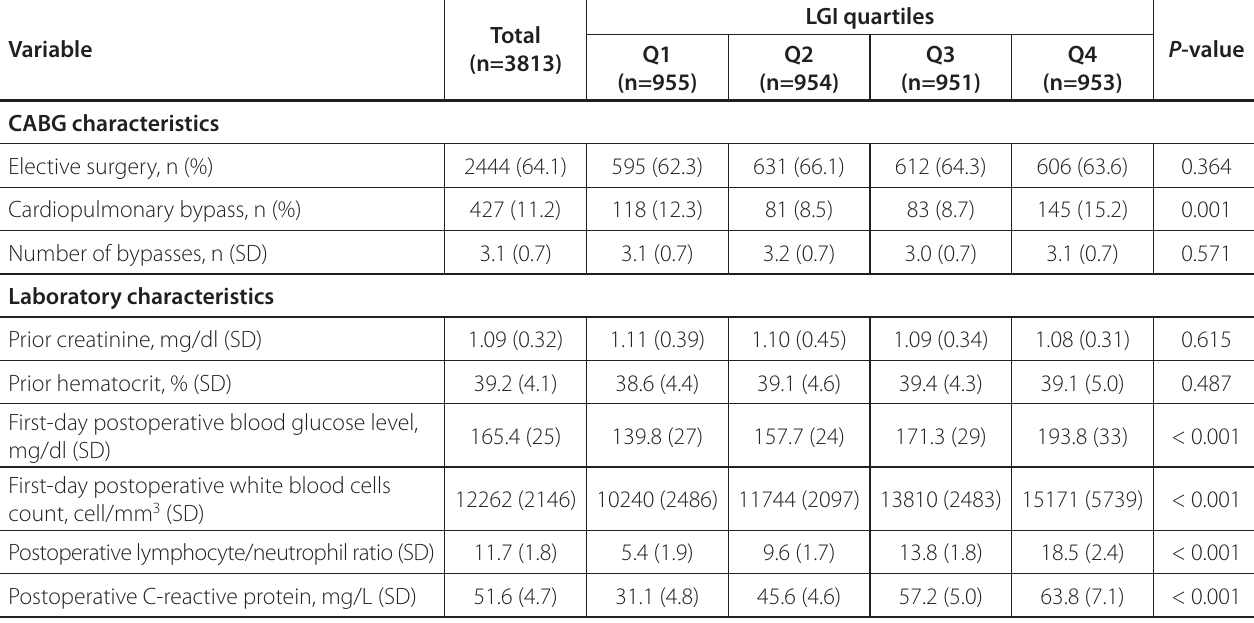
Table 2 . Surgical and laboratory characteristics according to